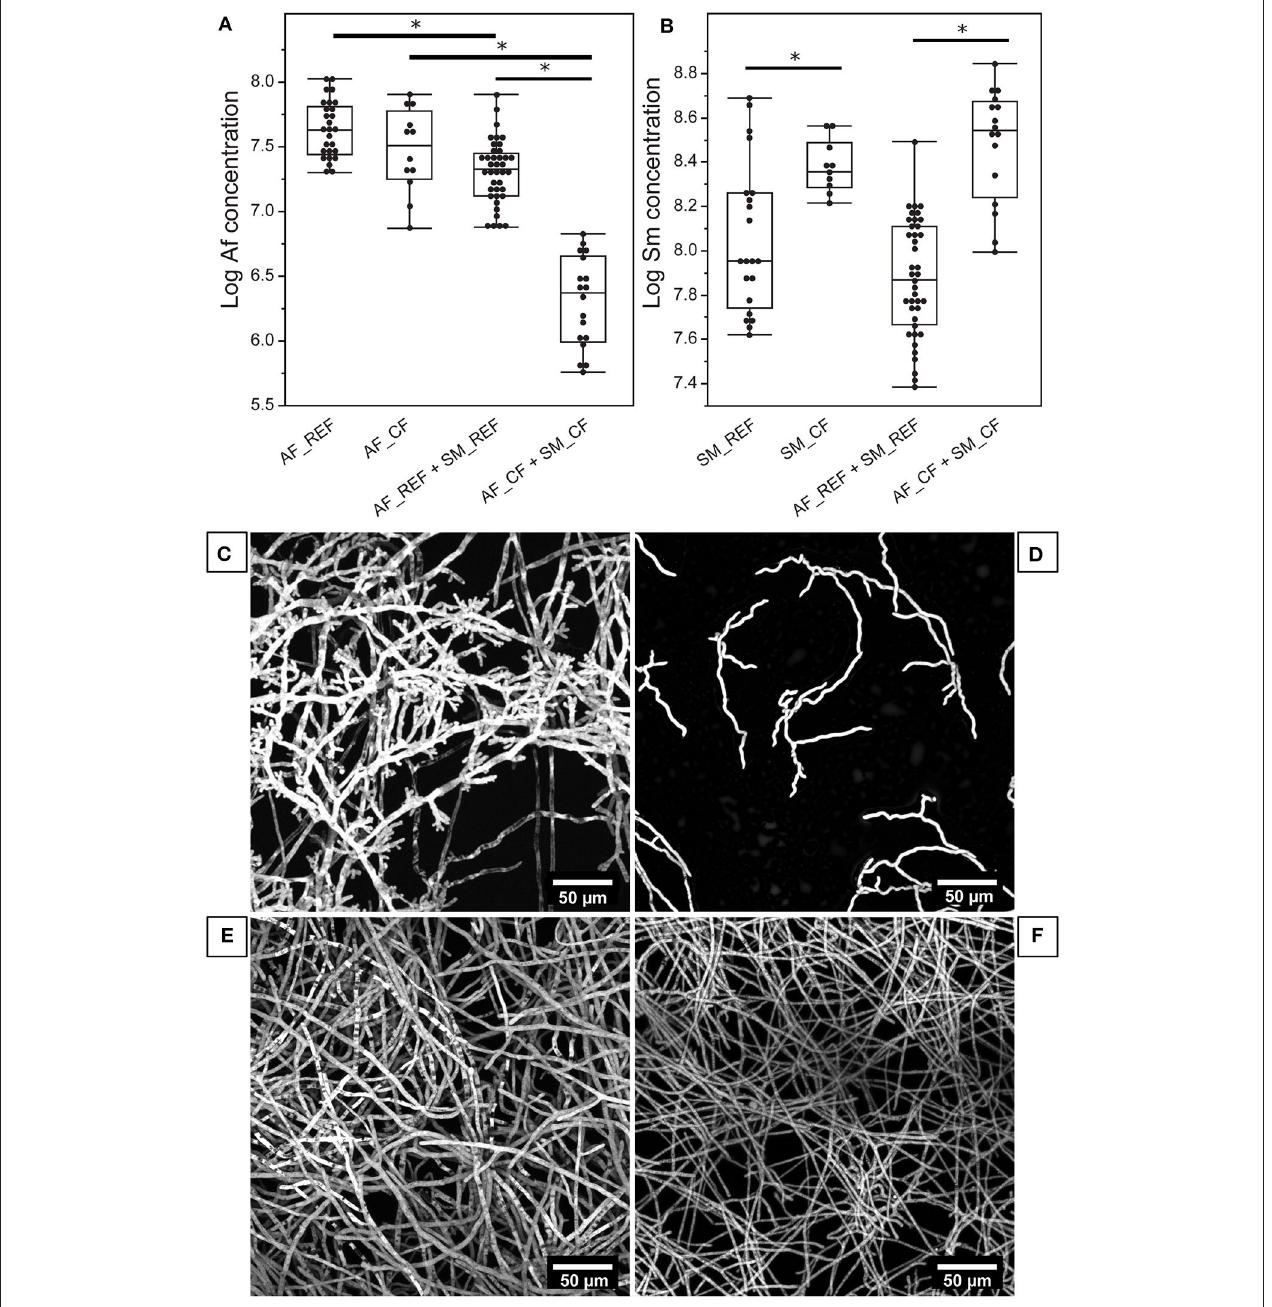
FIGURE 3 | Quantification of fungal and bacterial concentrations in biofilms and phenotype modifications of A. fumigatus in the presence of S. maltophilia . (A,B) Assessment of Af or Sm growth in mono- and polymicrobial biofilms after 24h of culture by qPCR. * p < 0.05. (C) AF_REF phenotype in polymicrobial biofilm with